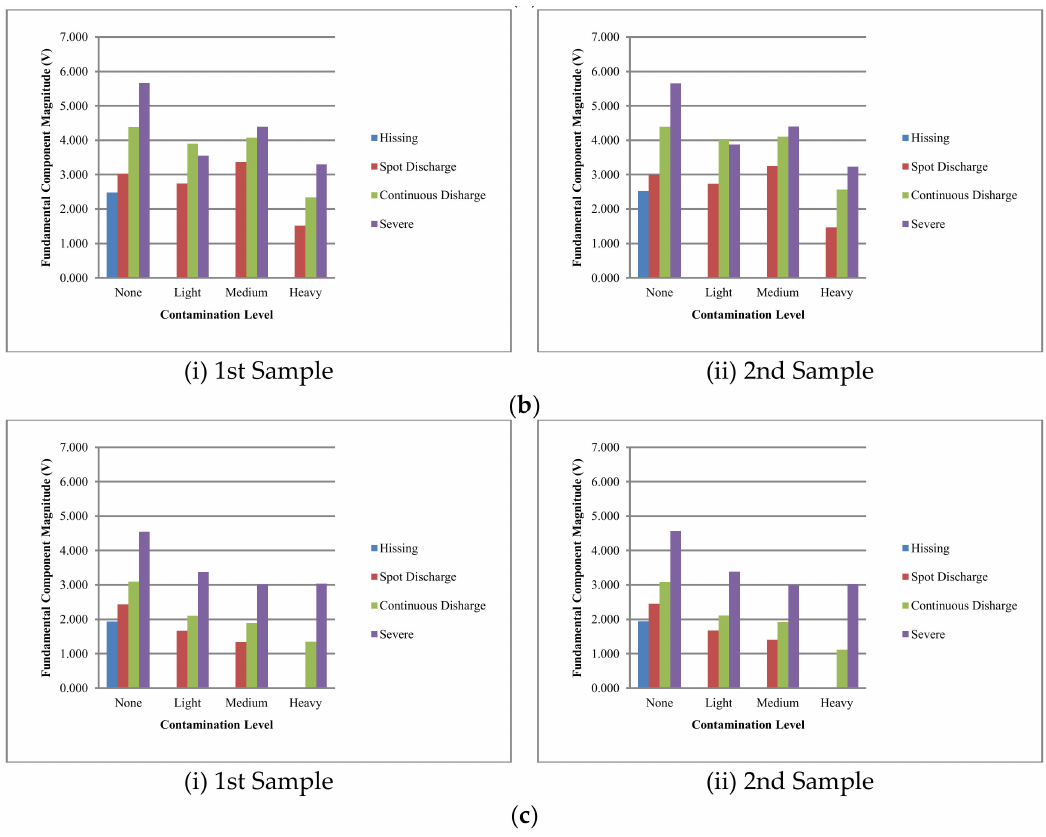
Figure 17. Fundamental frequency components for wet condition for samples: ( a ) Group A; ( b ) Group B; ( c ) Group C